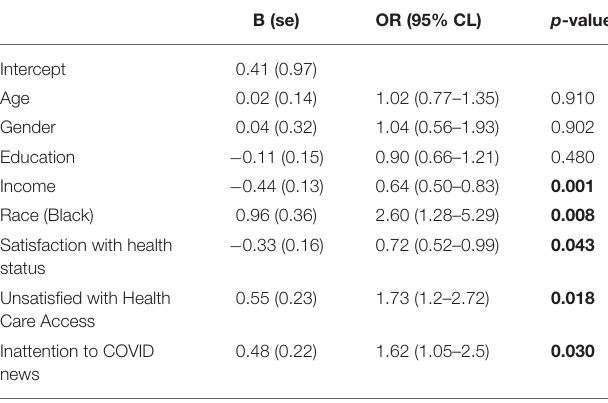
TABLE 2 | Logistic regression—associations with vaccine